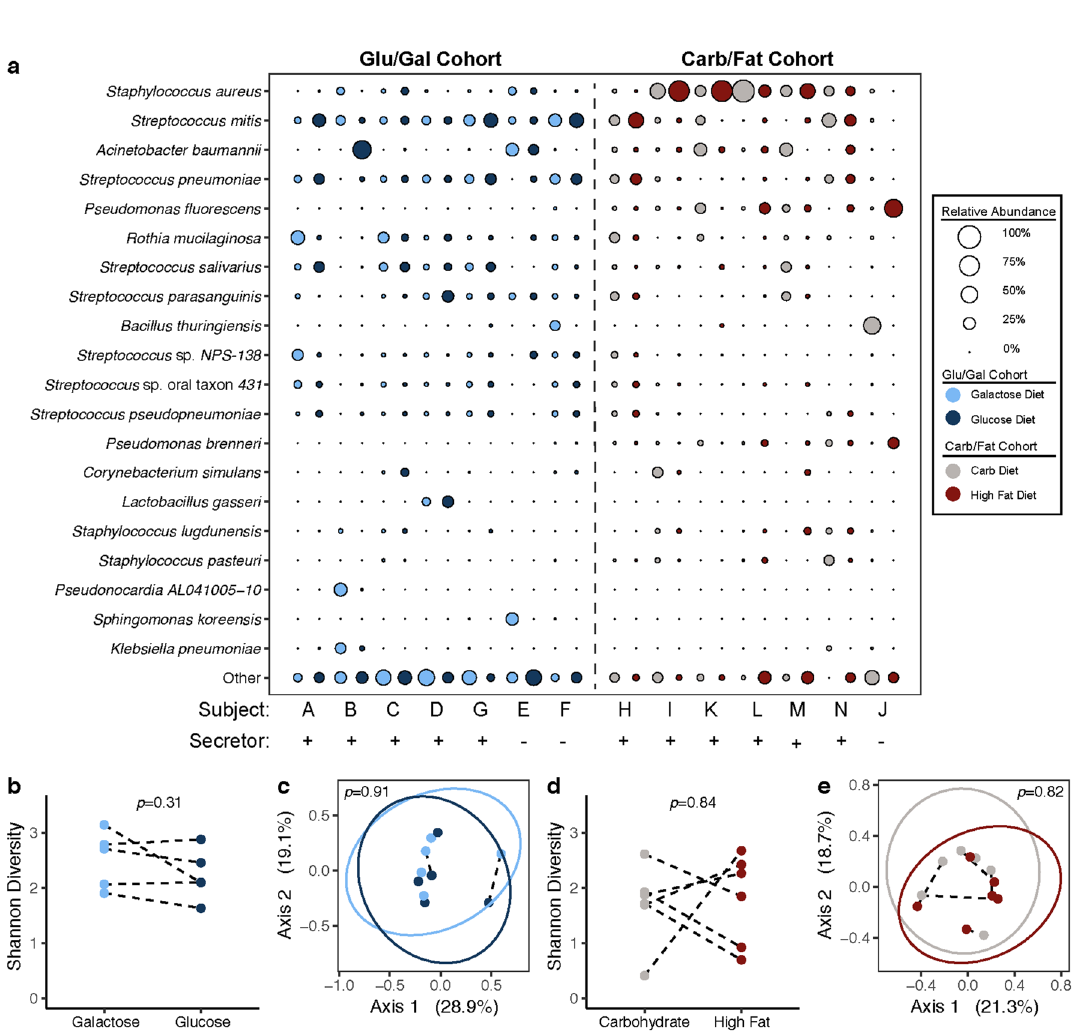
Figure 3. Species-level profile of milk microbiome by WGS sequencing reveals overall minimal discernable impact of maternal diet on taxonomic composition. ( a) WGS sequencing of the milk microbiome reveals relative abundance of most abundant bacterial species. No significant difference in alpha diversity by diet is detected in Glu/Gal Cohort ( b , p = 0.31, Mann–Whitney) nor Carb/Fat Cohort ( d , p = 0.84, Mann–Whitney). Principal coordinate analysis (PCoA, Binary Jaccard) of milk microbiome bacterial species reveals no significant clustering by diet in the Glu/Gal Cohort ( c , p = 0.91, PERMANOVA) nor Carb/Fat cohort ( e , p = 0.82, PERMANOVA). For panels ( b )–( e ), lines connecting points indicate paired dietary samples from the same subject. Ellipses indicate 95% confidence interval of group